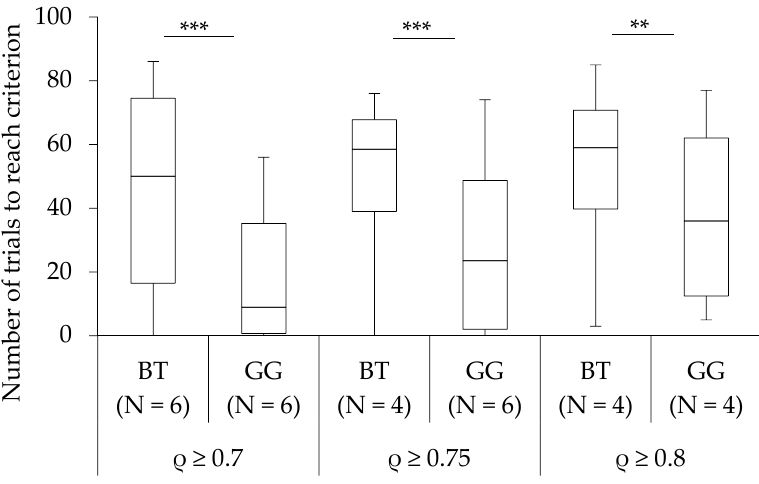
Figure 6. Box plot of three passing criteria, ρ ≥ 0.7 (or 70%), ρ ≥ 0.75 (or 75%), and ρ ≥ 0.8 (or 80%), to assess learning performance for pattern B for each species (BT = Blue-throated Macaws, GG = Great Green Macaws). *** p < 0.001, ** p < 0.01.